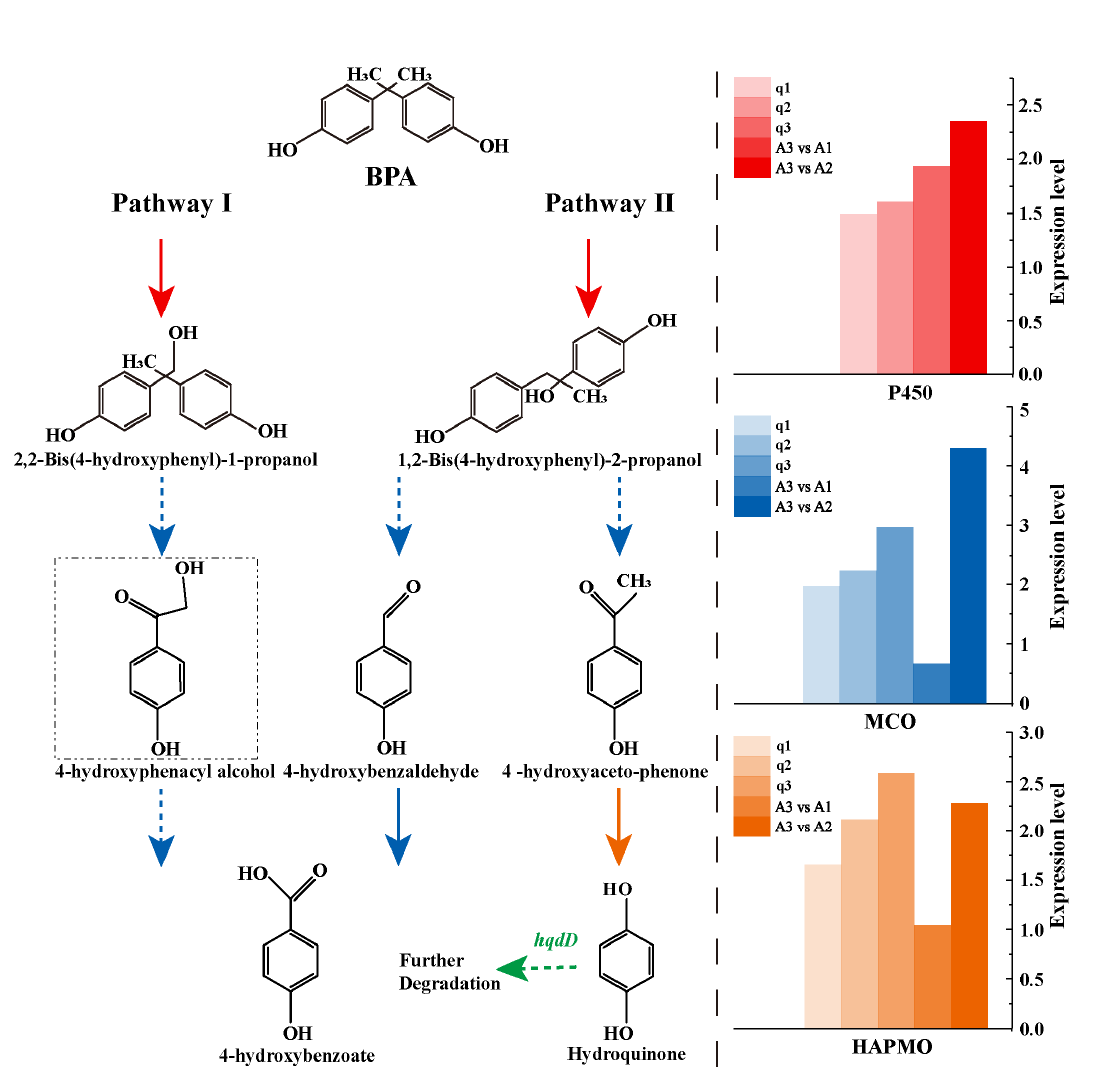
Figure 7. The putative BPA degradation pathway of strain R-001. 4-hydroxyphenacyl alcohol was not detected in LC-MS.